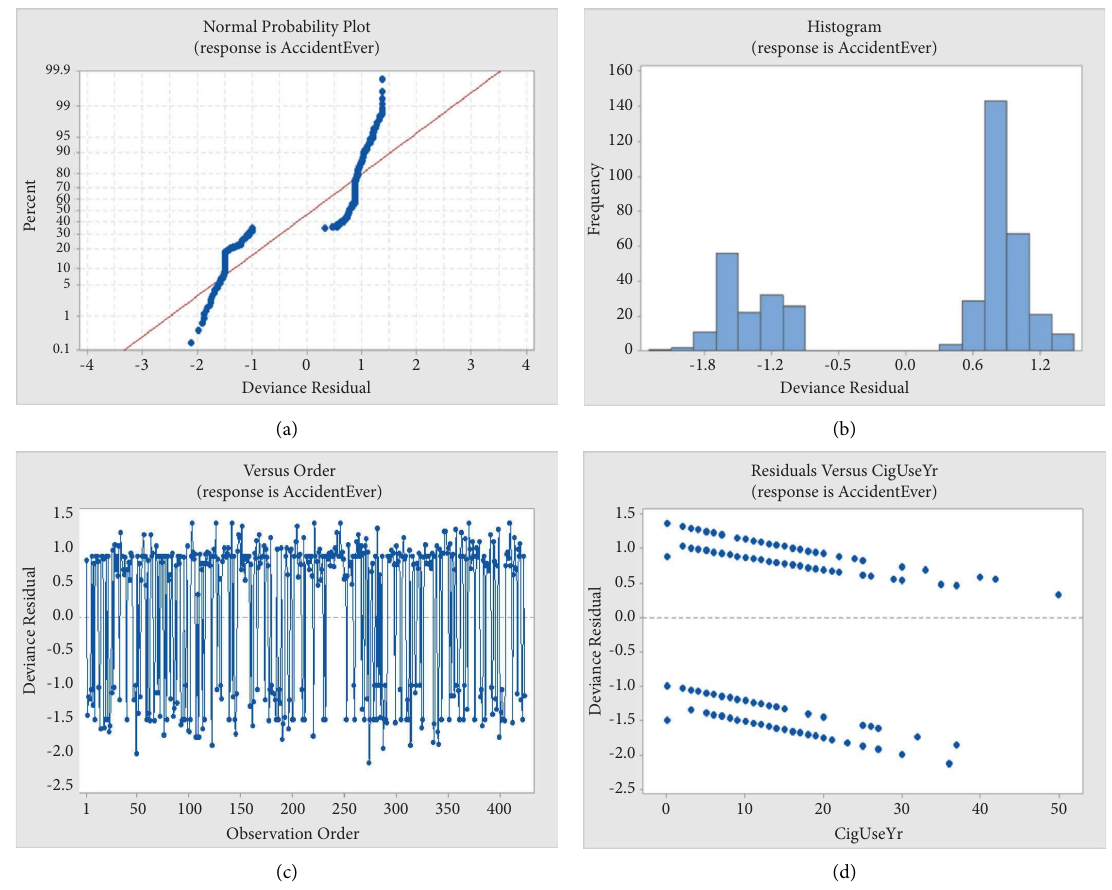
Figure 6: (a) Normal probability plot, (b) histogram of frequency versus deviance residual of the new binary logistic regression model, (c) versus order plot, and (d) deviance residual versus CigUseYr